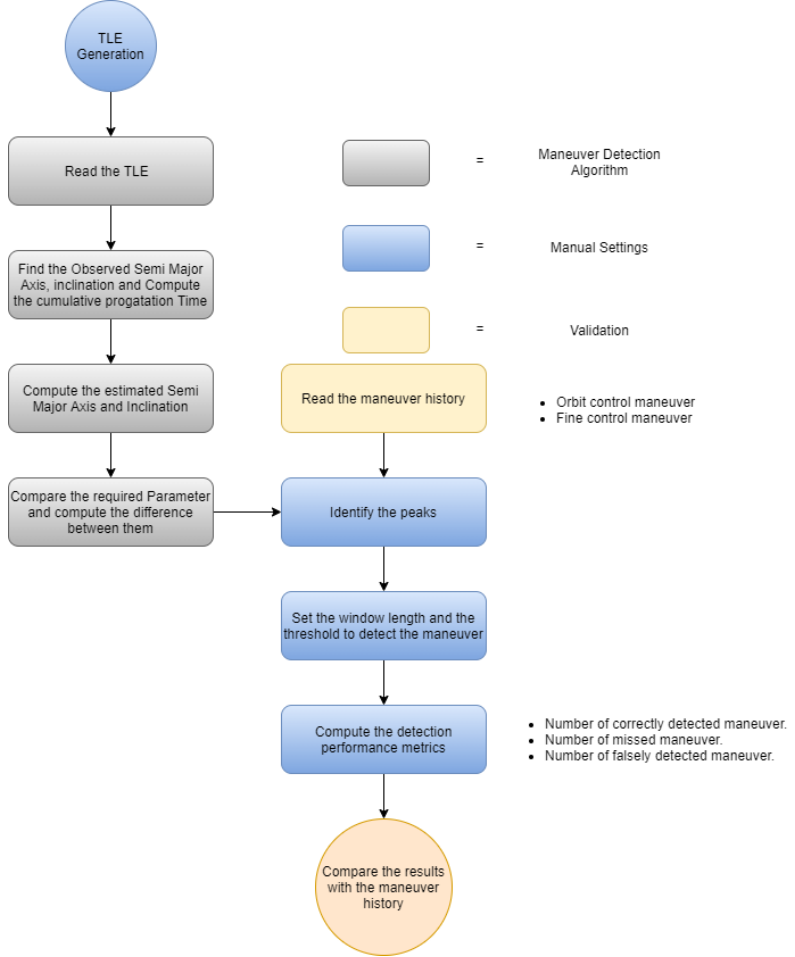
Figure 1. Maneuver detection and analysis algorithm. Once the differences between the corresponding propagated and observed orbital parameters were found, potential maneuvers were marked when the difference between the adjacent values exceeded a user-specified detection limit. For example, as shown in Figure 2, two potential maneuvers of TOPEX are flagged as red dots when the difference between the adjacent values exceeds a user-specified detection limit, which is represented as a horizontal green line (see Supplement Section 2 for pseudo-code used in this algorithm). The plot is a time function, which forms a peak that represents the sudden change found in the difference between the observed and propagated orbital parameters. The results of